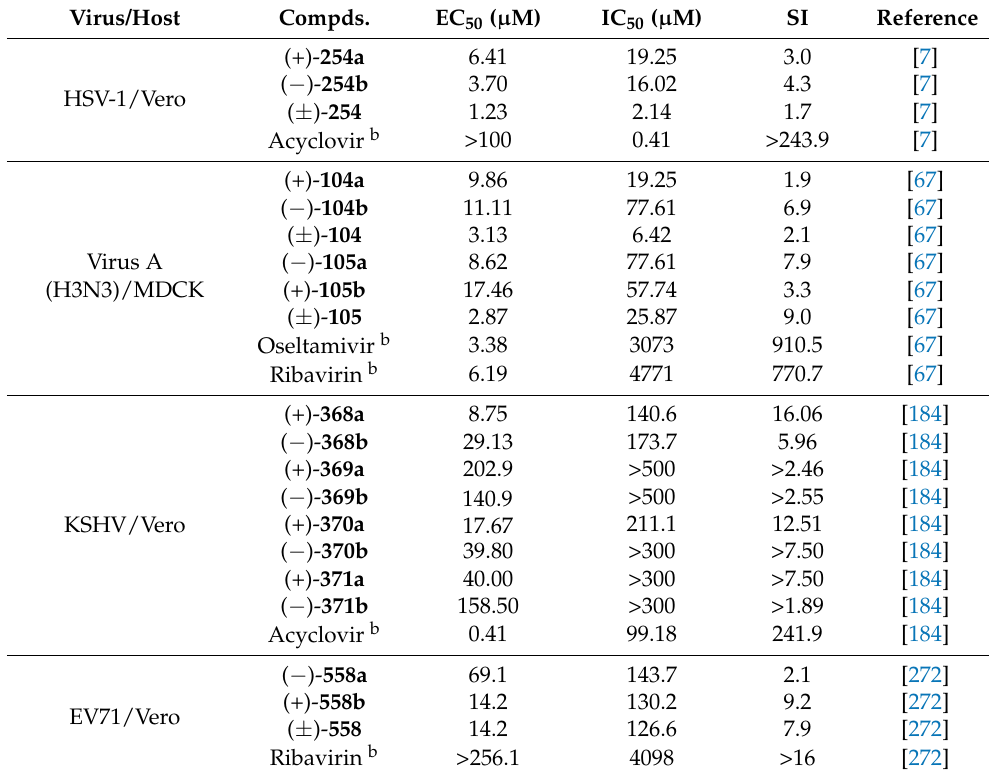
Table 3. Antiviral activities of enantiomers a . Virus/Host